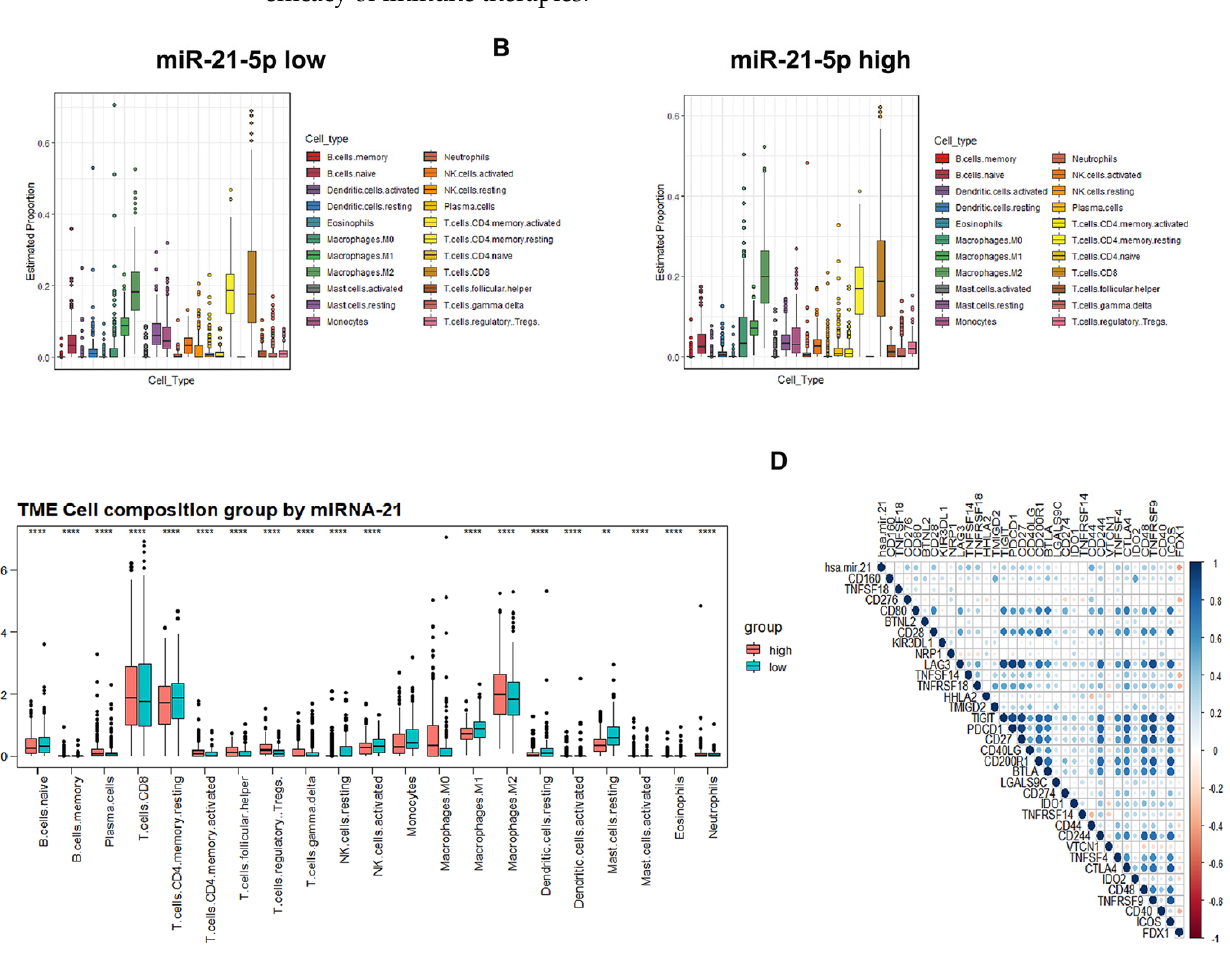
n.s. = no significance.